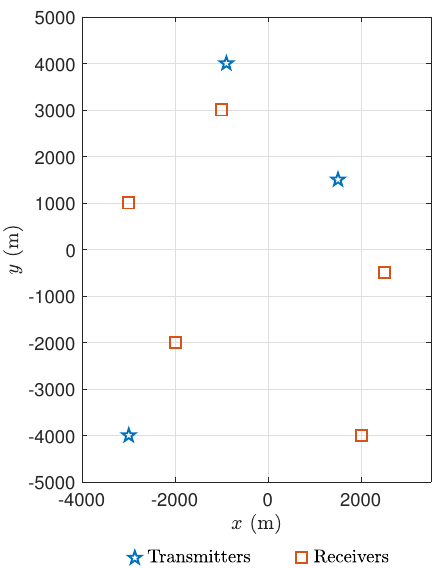
Figure 2. Nominal location geometry for computer